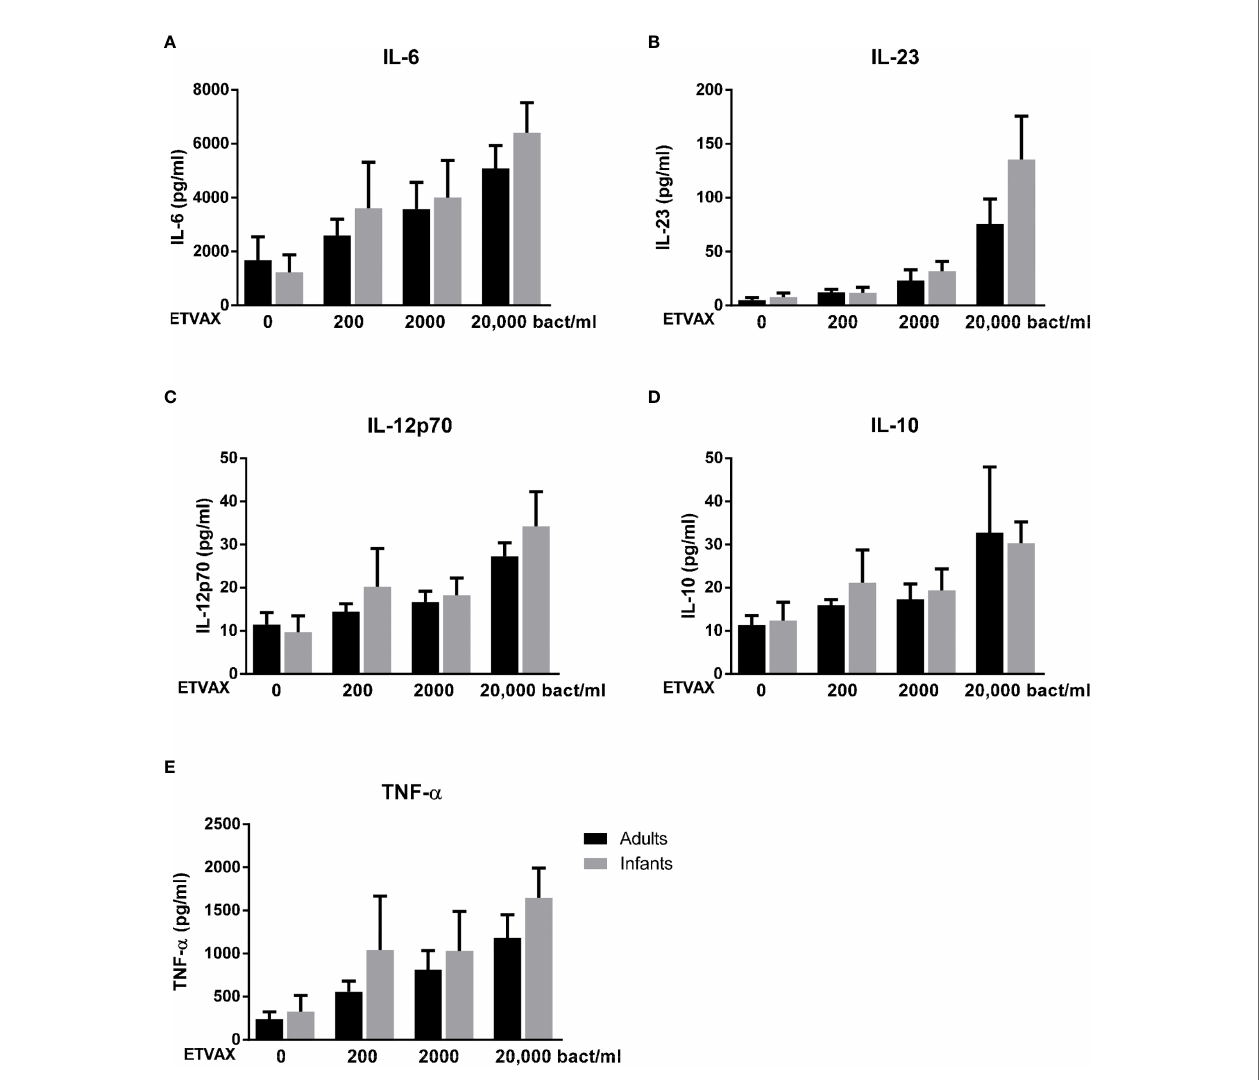
FIGURE 8 | Production of IL-6, IL-23, IL-12p70, IL-10 and TNF- a from PBMCs stimulated with ETVAX WCC. Cytokine concentrations in cultures with PBMCs from adults (n = 5) and infants (n = 5) stimulated with increasing concentrations of ETVAX WCC (200-20 000 bacteria/ml). Bars represent mean with SEM of concentrations of (A) IL-6, (B) IL-23, (C) IL-12p70, (D) IL-10 and (E) TNF- a in culture